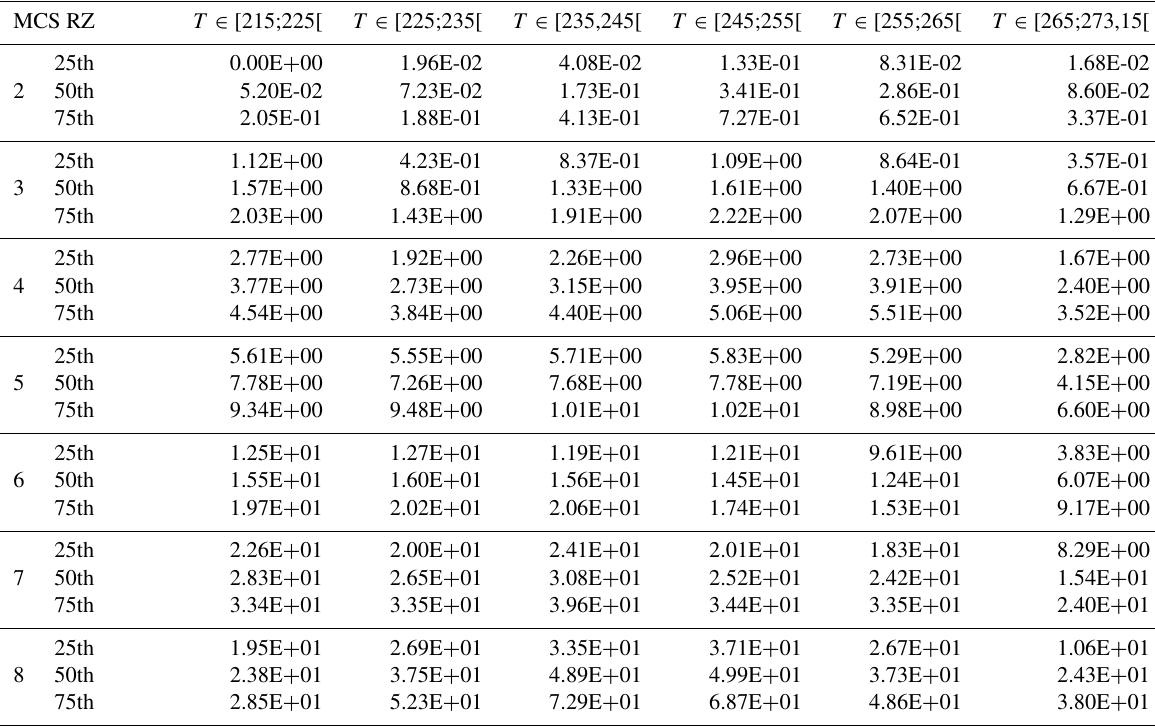
Table C6. Total concentration from 500µm ( N T 500 ) in L − 1 (Fig. 11).